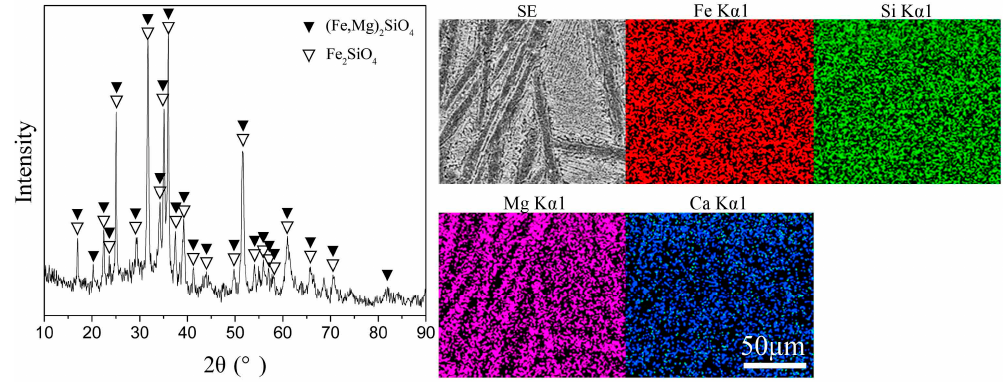
Figure 1. XRD patterns and elemental scanning maps of water-quenched nickel slag.